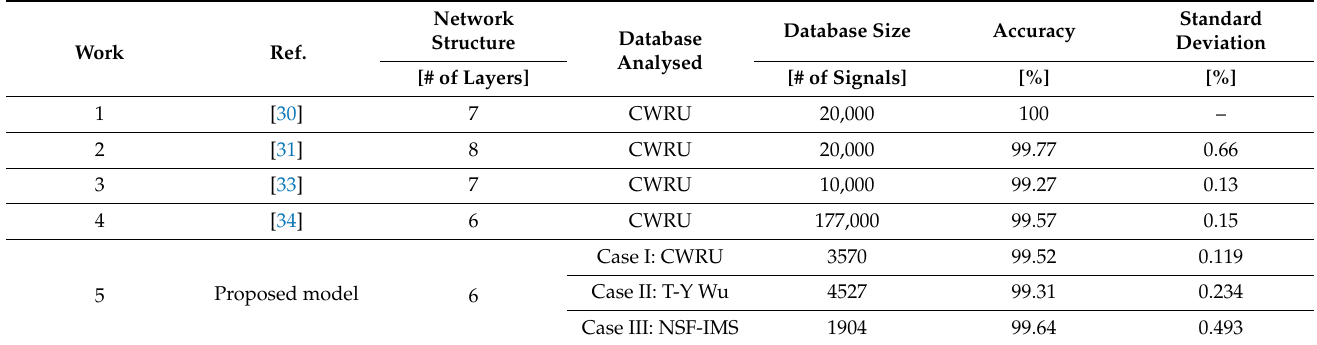
Table 8. Comparison of the results obtained by the proposed model with other